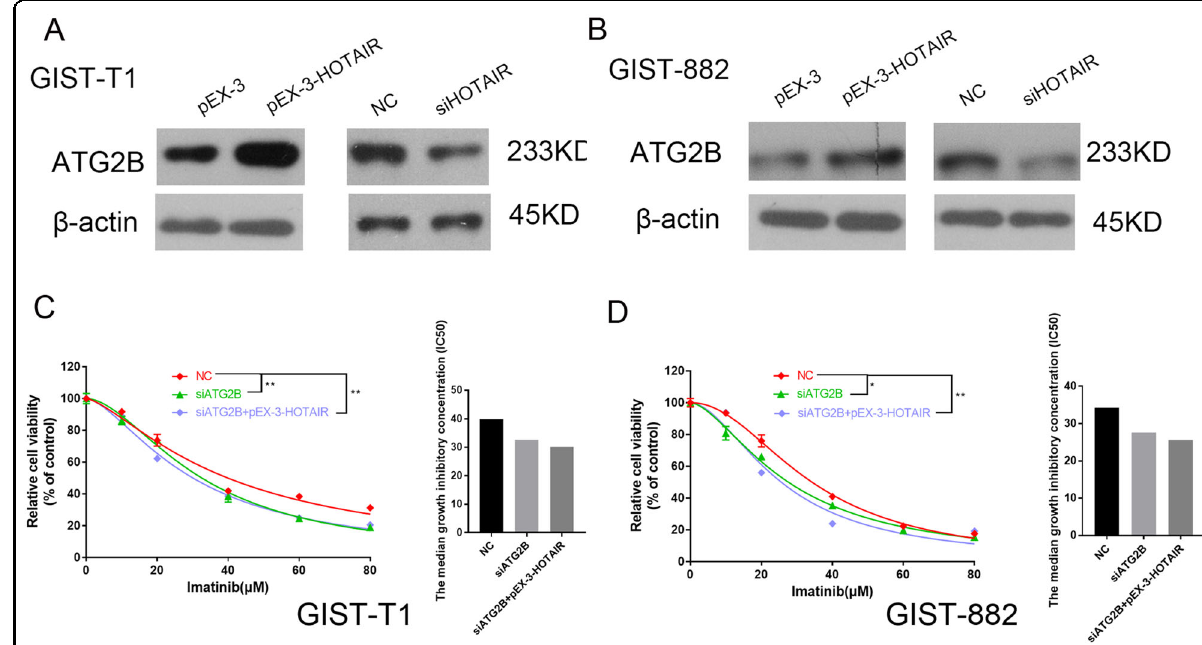
Fig. 6 HOTAIR also regulates ATG2B levels. A , B The results of western blotting showing that HOTAIR regulates the expression of ATG2B . C , D The ATG2B siRNA or the ATG2B siRNA and the HOTAIR siRNA together were transfected into the GIST cells, and the resultant changes in cell viability after imatinib treatment were estimated through the CCK-8 assay. * P < 0.05; ** P < 0.01 vs.